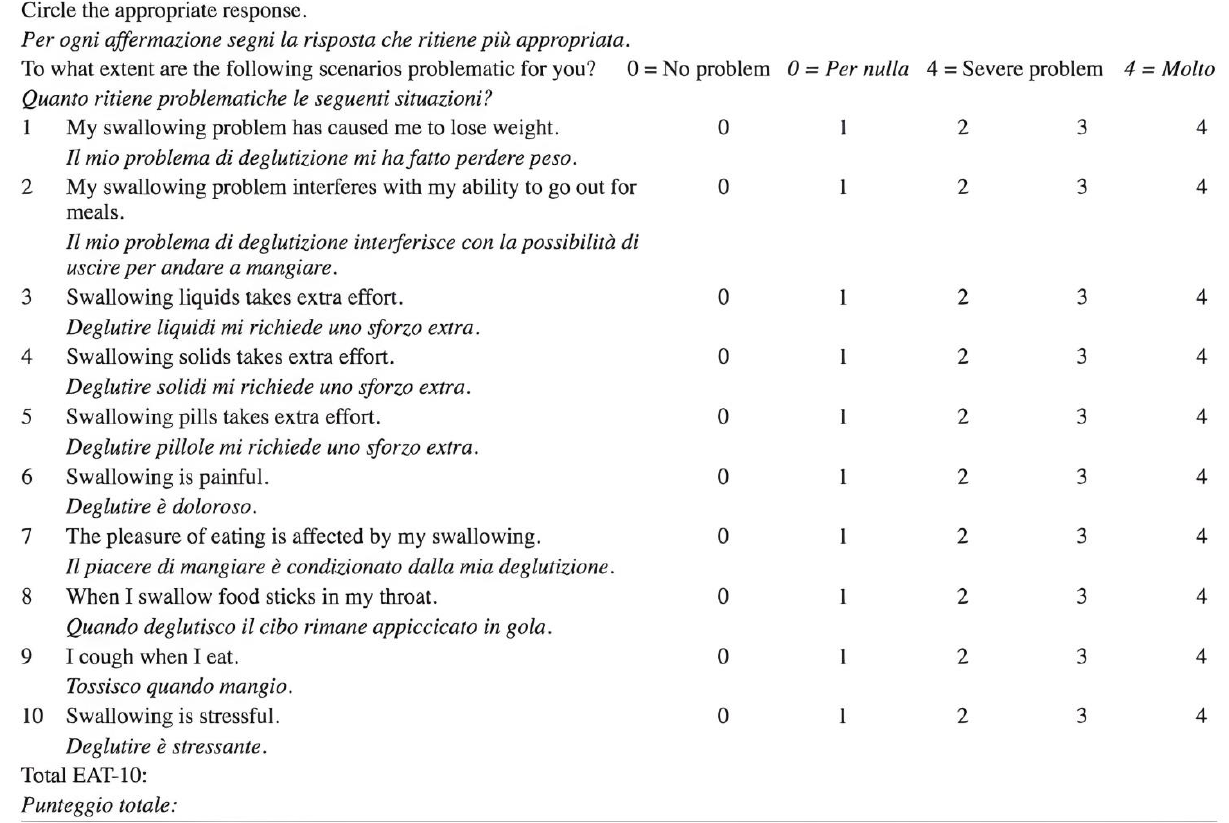
Figure 2. Italian EAT-10 Questionnaire [26].